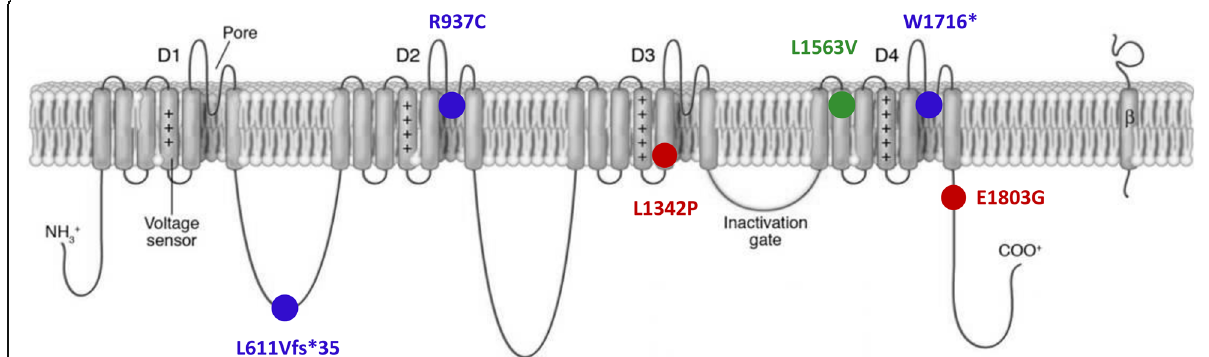
Fig. 1 Schematic drawing of SCN2A indicating the location of studied pathogenic variants. The three patients with ID without seizures carried de novo heterozygous variants in SCN2A (shown in blue), two of which are nonsense variants (p.L611Vfs*35 and p.W1716*) and one is a missense variant in the pore-forming loop of domain 2 of the channel (p.R937C). The two patients with early onset EE harbored de novo heterozygous missense variants (shown in red) in the fifth transmembrane segment of the third channel domain (p.L1342P) or the C-terminal domain (p.E1803G), respectively. The heterozygous inherited missense variant previously reported by others in a family with BFNIE (Heron et al. 2002) (shown in green) is located in the second transmembrane segment of domain 4 (p.L1563V). Adapted from Meisler and Kearney